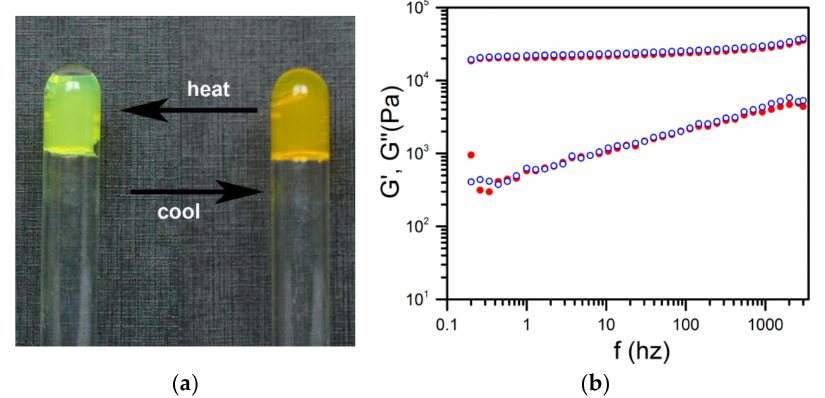
Figure 4. ( a ) Change of colour of the hybrid gel upon heating and cooling cycles. As long as temperature remained below the polymer gel melting point, the hybrid system remained a macroscopic gel [10]. ( b ) Rheological properties of the hybrid gel ( ) versus those of the binary sPS gel ( ); the solvent was (cid:35) trans-decahydronaphthalene (unpublished data J.M. Guenet, D. Collin [11], Institut Charles